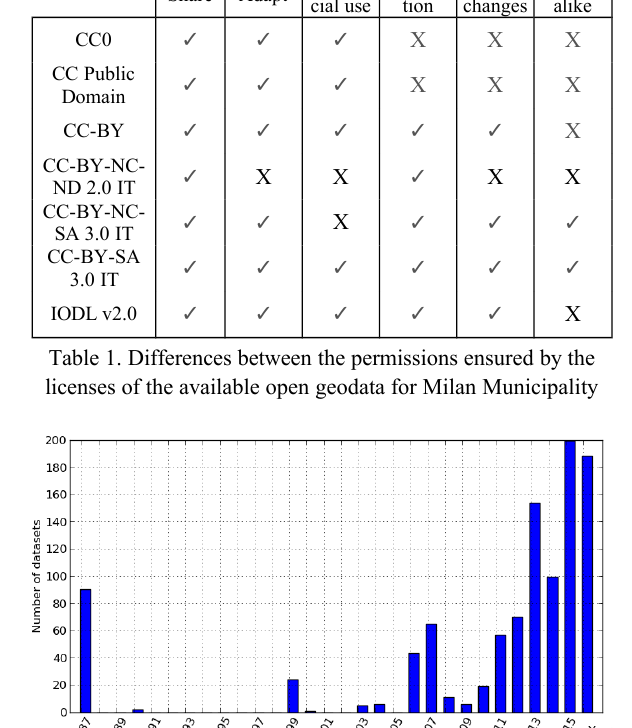
Figure 3. Classification of the open geodata available for Milan Municipality according to the year of publication.